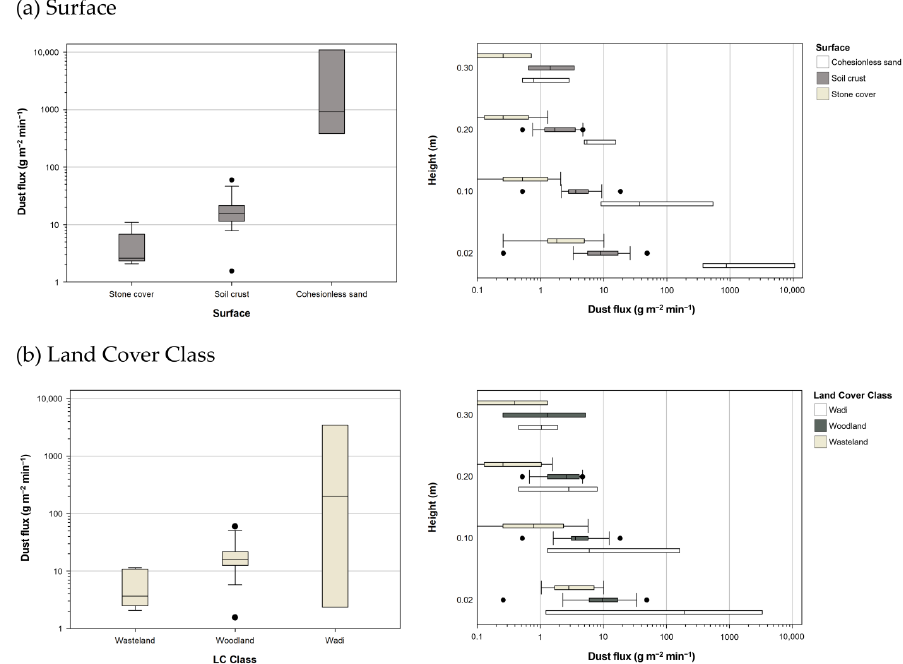
Figure 6. Horizontal mass flux total and in different measurement heights with respect to ( a ) surface and ( b ) LCC. Solid lines show the medians, dots the outliers and whiskers mark the 10. and 90. percentile.